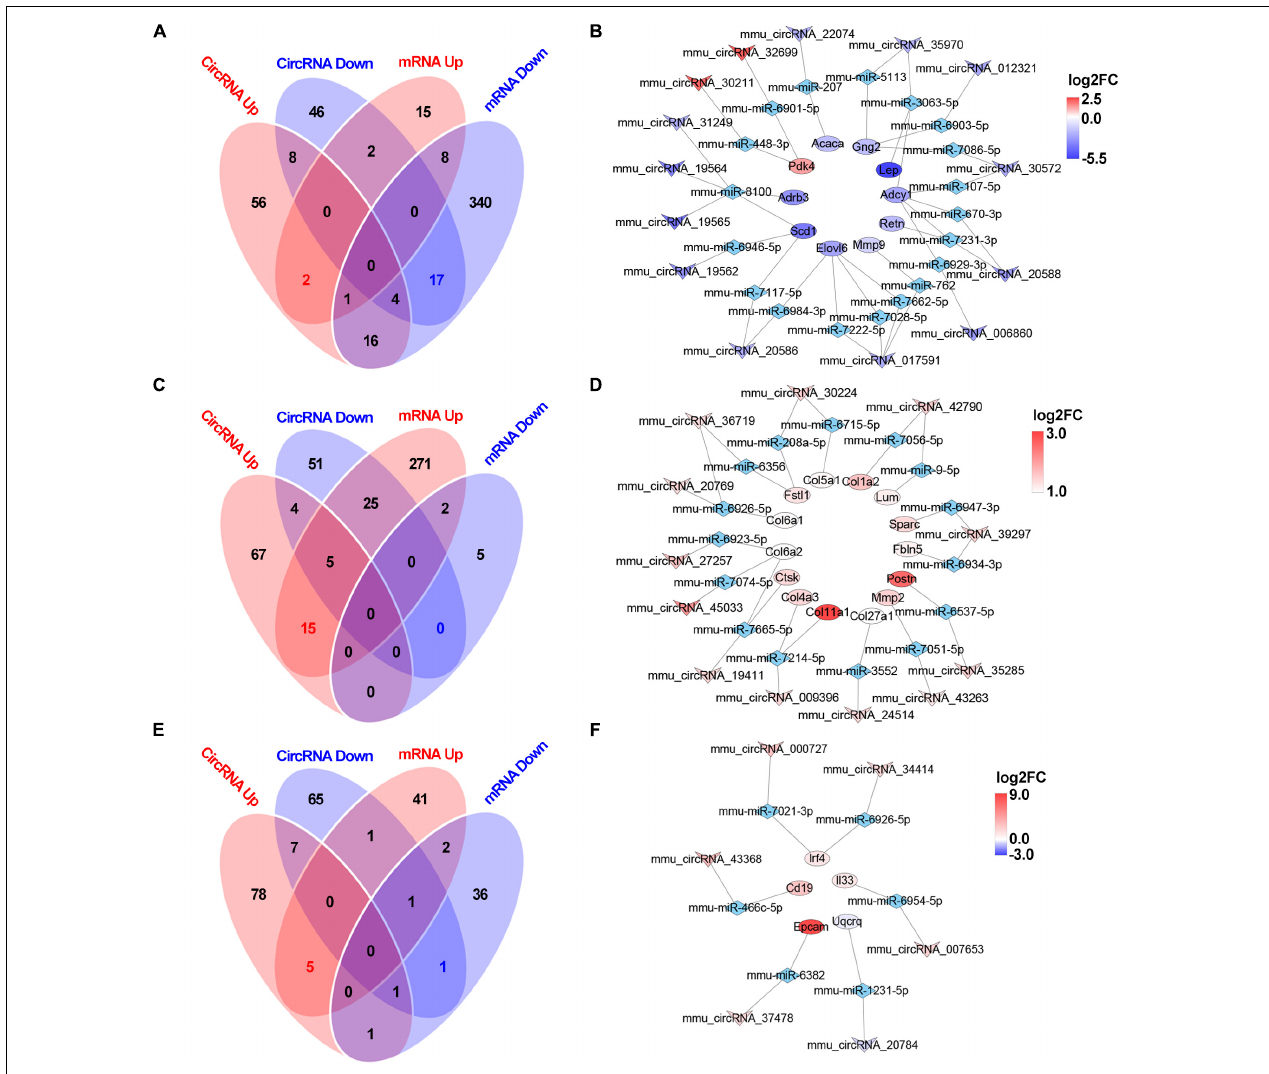
FIGURE 10 | Circular RNA-based ceRNA networks in the 2W-, 4W- and 8W-post TAC hearts. The miRNAs interacting with the mRNAs or circRNAs in the 2W-post-TAC hypertrophic stage were displayed in panel (A) . The constructed ceRNA networks illustrated that the target mRNAs encoding adrenergic signaling, pyruvate metabolism, metabolic regulators, and matrix metallopeptidase in the hypertrophic hearts (B) . The miRNAs in the 4W-post-TAC HFpEF stage were displayed in panel (C) . The circRNAs were predicted to regulate mRNAs associated with collagens and matrix regulators, and adipokine (D) . The miRNAs in the 8W-post-TAC HFrEF stage were displayed in panel (E) . The circRNAs were predicted to regulate mRNAs associated with inflammatory regulation and a mitochondrial enzyme (F) . N = 2 for the sham, 2W-, 4W-, and 8W-post-TAC groups. Red, upregulated mRNAs modulated by circRNA-based ceRNA network; blue, downregulated mRNA modulated by circRNA-based ceRNA network; the colors from deep to light reflect the P -value from high to